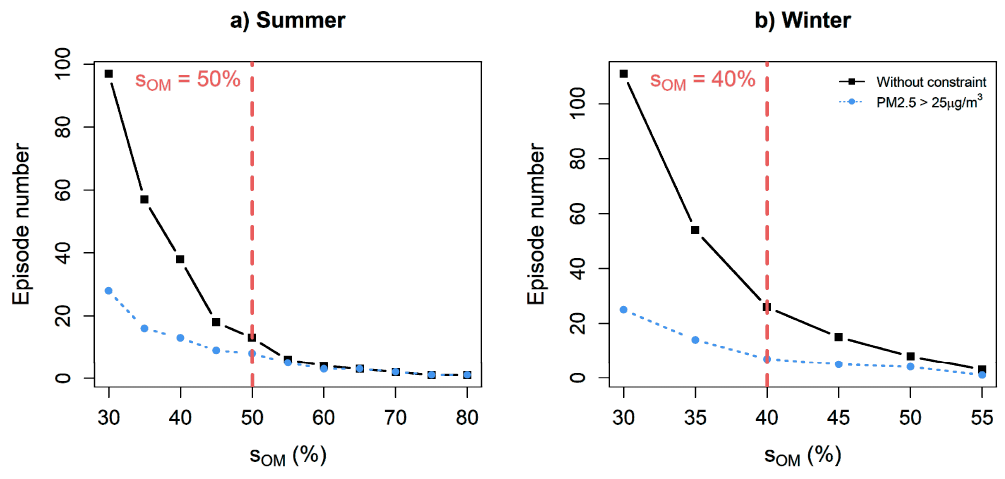
Figure 2. Number of EM episodes according to the chosen preliminary EM threshold s OM . In winter, Figure 2b indicates that a large number of EM episodes are not linked to important amount of air pollution. The blue curve showing the number of episodes with PM 2.5 larger than 25 µg/m 3 rapidly decreases until 𝑠 (cid:3016)(cid:3014) = 40% . We therefore chose 𝑠 (cid:3016)(cid:3014) = 40% for winter, which is slightly lower than in summer, consistently with the summary statistics of EM shown in Table 2.